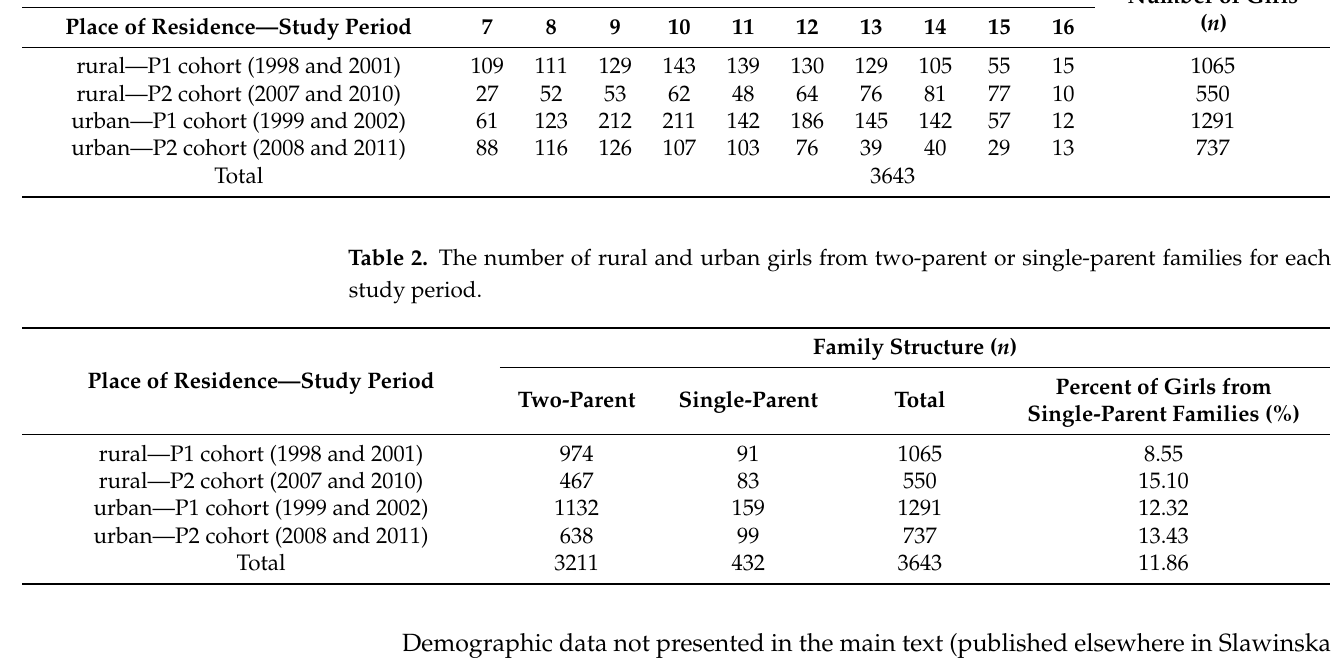
Table 1. The number of rural and urban girls grouped by age for each study period. Age (Years)